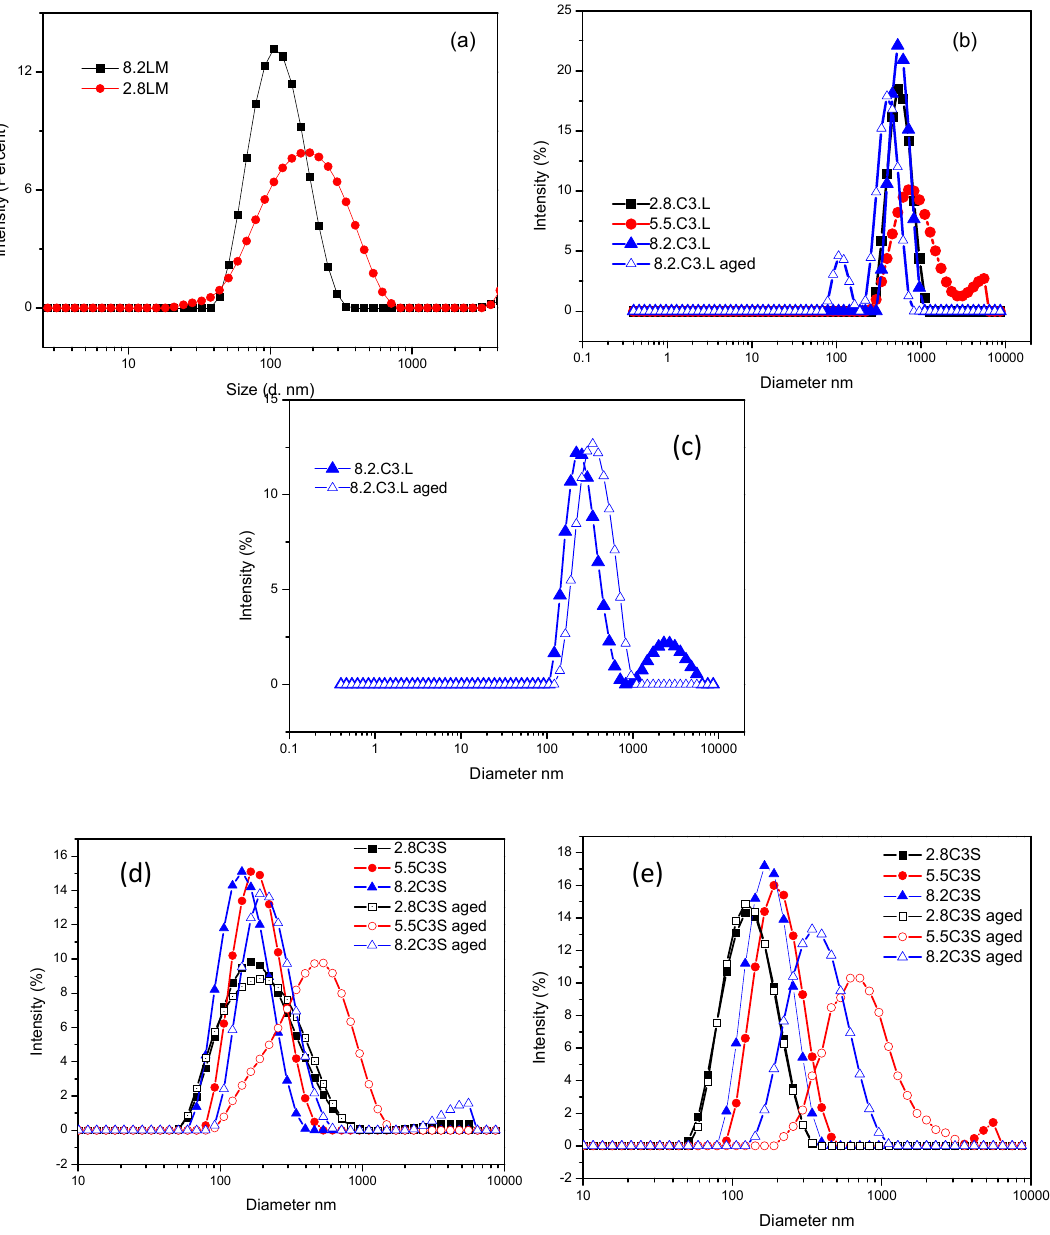
Figure 5. Size distribution (diameter Dh) for the binary mixtures of ( a ) LM ( b ) C3L 1 mM day 0 and day 20 ( c ) C3L 5 mM day 0 and day 20, ( d ) C3S 1 mM day 0 and day 20, and ( e ) C3S 5 mM day 0 and day 20.